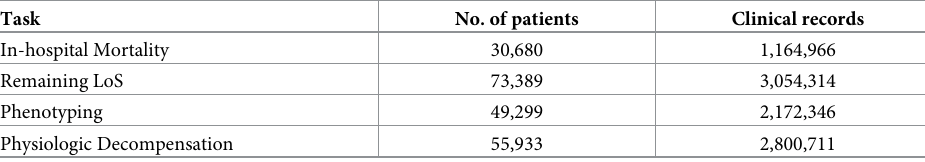
Table 3. Number of patients and records in four tasks.